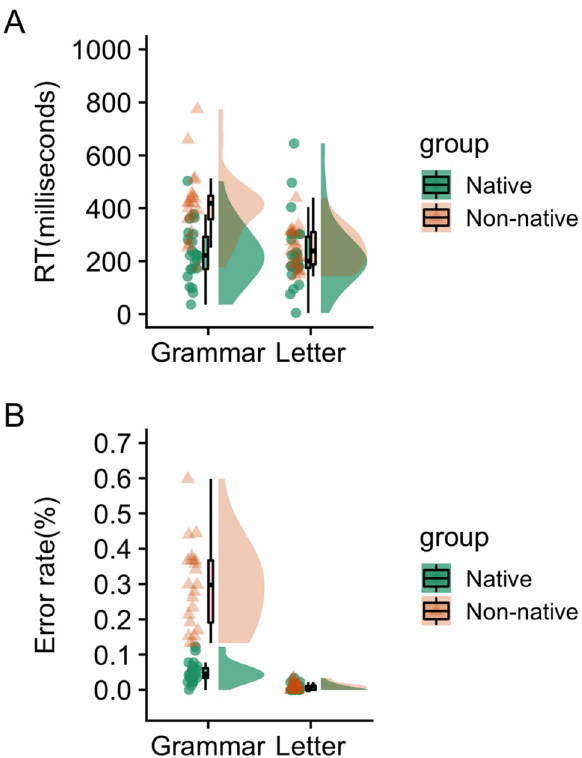
Figure 2. Behavioral results. Non-native learners demonstrated significantly ( A ) longer reaction times and ( B ) higher error rates than native speakers. Data are presented as box plots and violin plot datasets for each